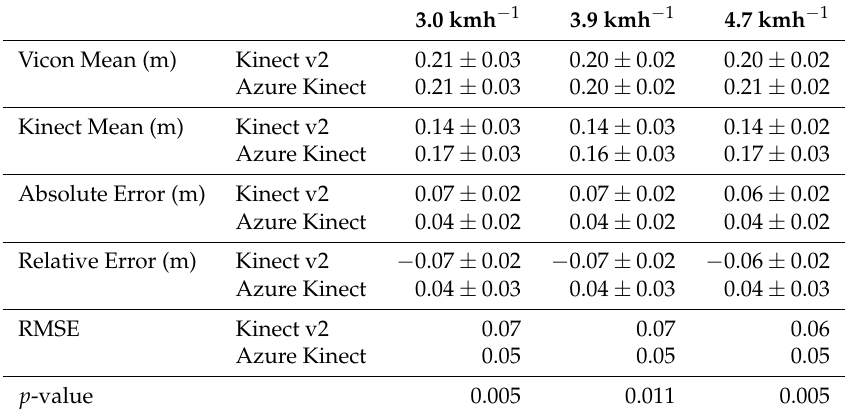
Figure 10. Step Width for Kinect v2 and Azure Kinect aggregated over all three speeds. Table 5. Step width gait parameter evaluation.